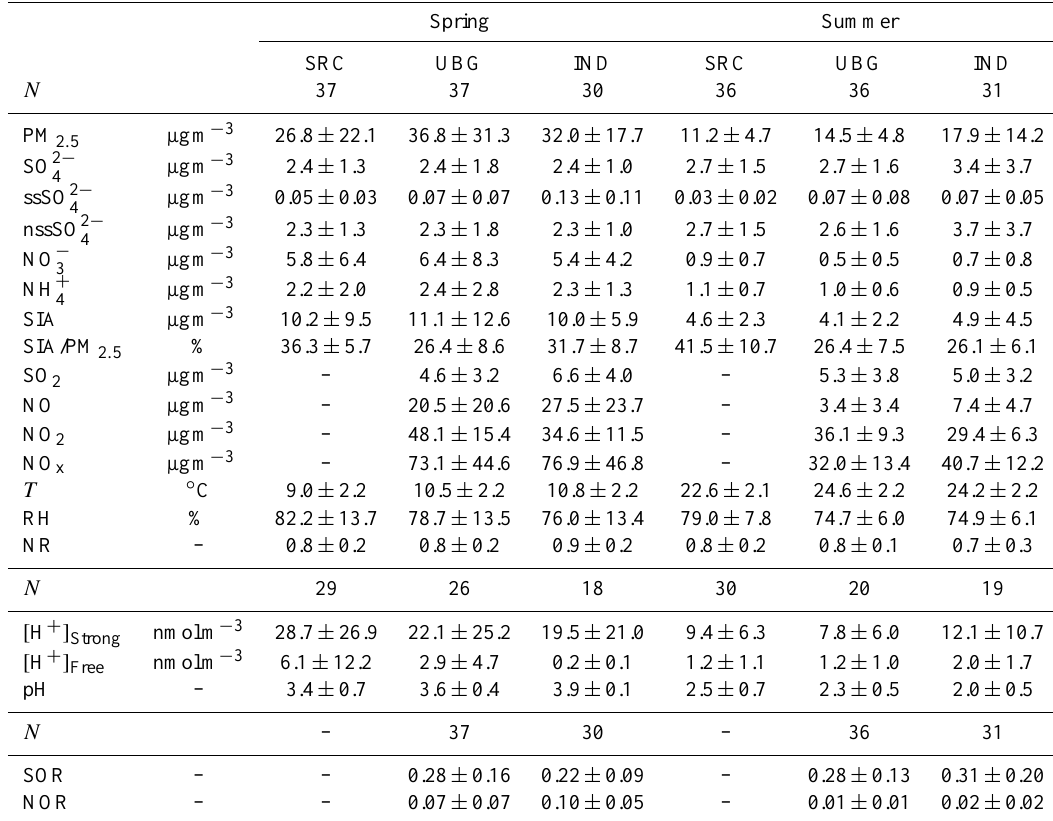
Table 1. Descriptive statistics (mean ± standard deviation) of experimental data (gases, ions, weather parameters), neutralization ratio, [ H + ] [ H + ] Free , pH) and oxidation ratios (SOR and Strong , E-AIM4 results (